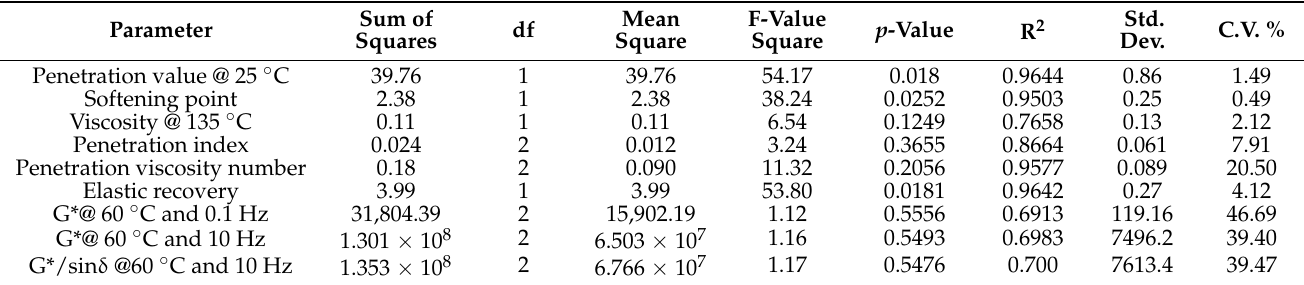
Table 3. Analysis of variance results summary at various LENR contents.